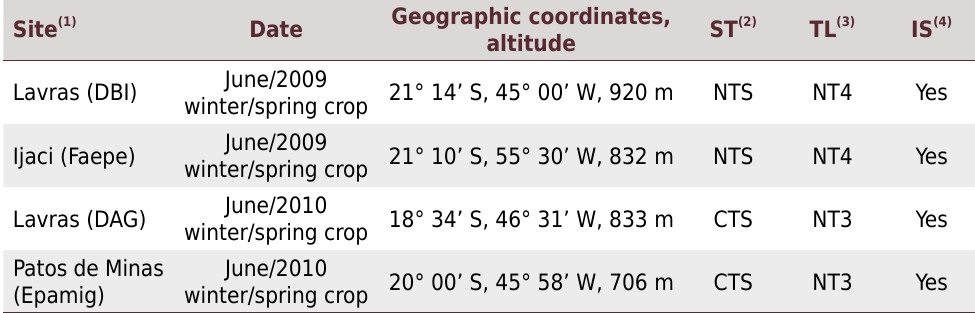
Table 1. Sites, date, geographic coordinates, soil preparation, technological level and irrigation system used in the experiments Site (1)